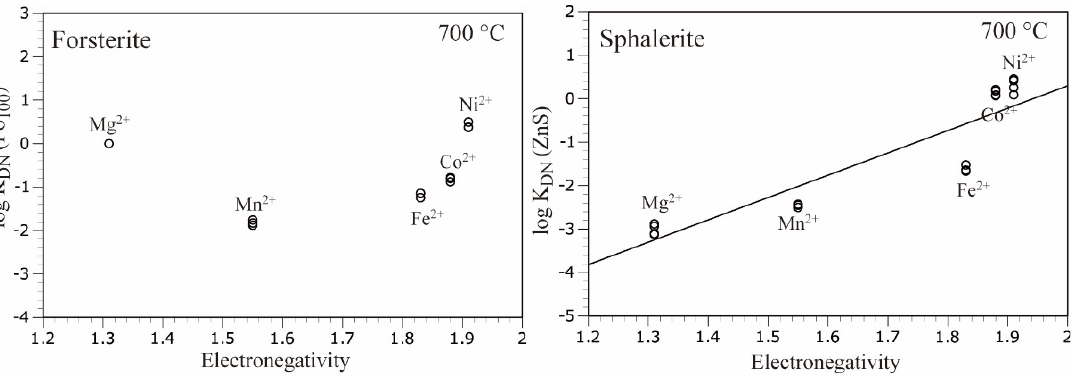
Figure 4. Logarithmic distribution coefficient (log K DN ) vs. electronegativity (Pauling) diagrams for olivine (Fo 100 ) and sphalerite, except for Zn 2+ . Electronegativity data were taken from Emsley [26]. Distribution coefficient values for sphalerite were taken from Uchida et al. [16].